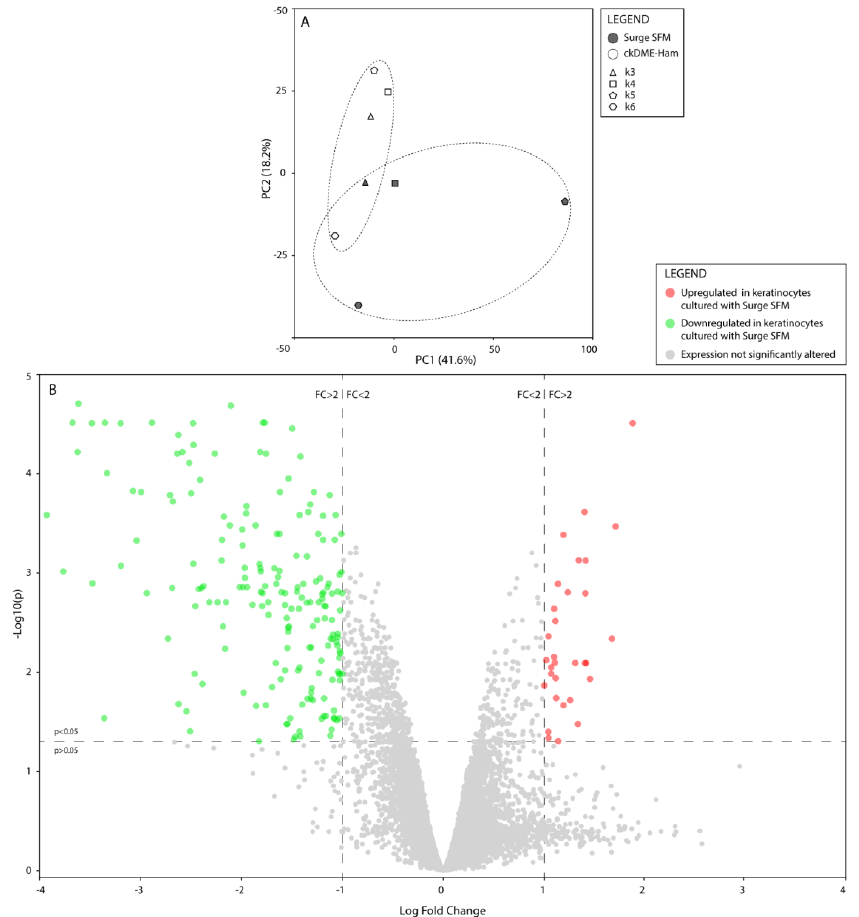
Figure 4. ( A ) Principal component analysis of normalized and filtered gene expression data. Dot fill colors indicate the medium used to culture keratinocytes (gray: Surge SFM and white: ckDME-Ham). Dot shapes identify keratinocyte populations (k3: triangle, k4: square, k5: pentagon, and k6: hexagon). Dotted ellipses represent both medium type clusters. ( B ) Volcano plot illustrating the results of the paired differential analysis of gene expression between keratinocytes cultured with Surge SFM and those cultured with ckDME-Ham. Dots represent individual genes. Gray genes’ expression was not significantly altered by culturing keratinocytes with Surge SFM rather than ckDME-Ham as opposed to colored genes whose expression was significantly ( p < 0.05) modified by at least a 2-fold change in either direction (green: downregulated and red: upregulated).